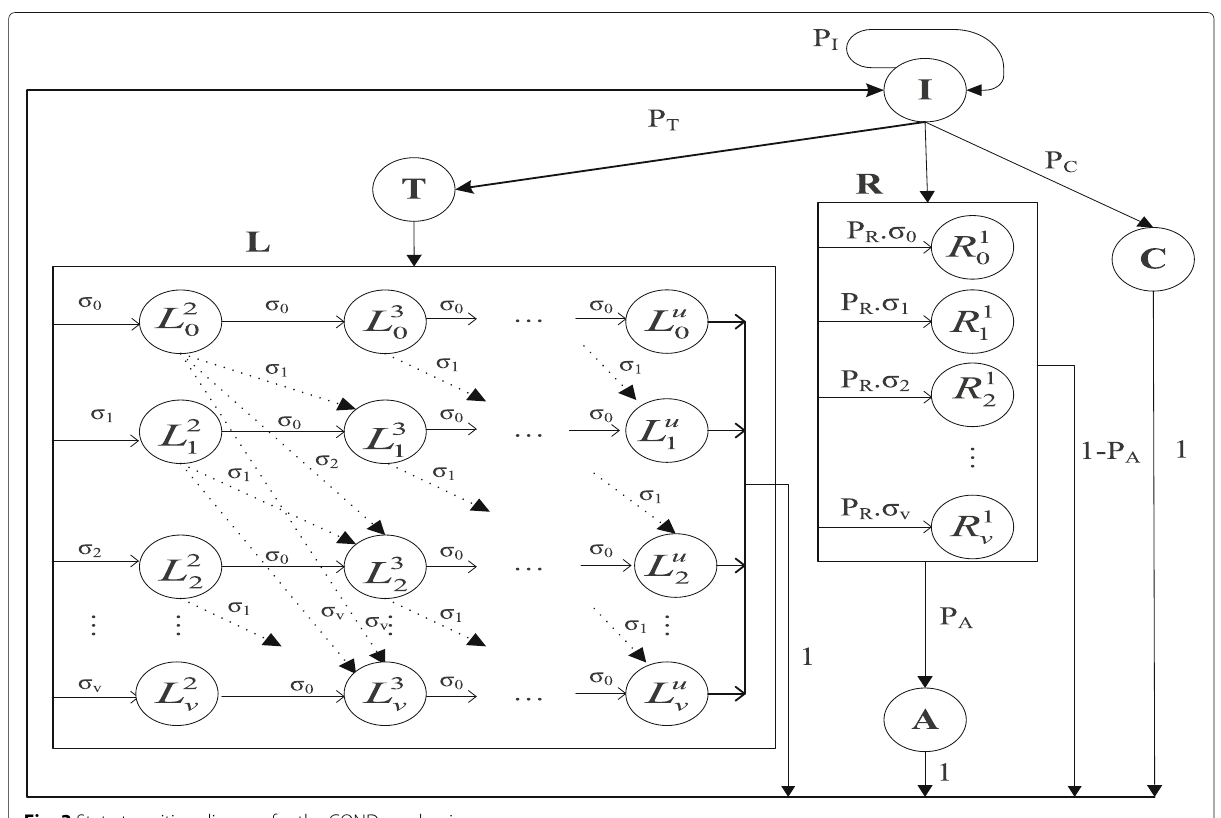
Fig. 3 State transition diagram for the COND